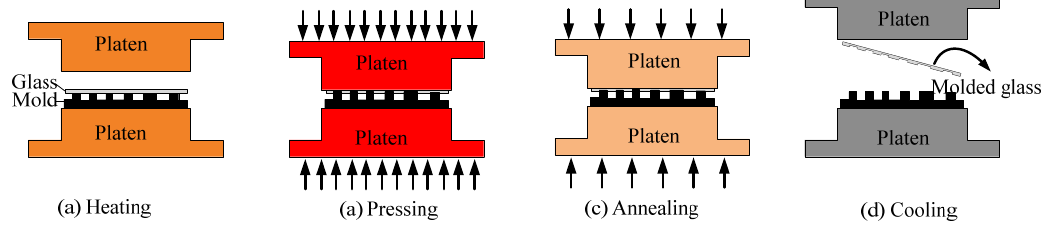
Figure 2. The schematic photo of the GMP. ( a ) Heating; ( b ) Pressing; ( c ) Annealing; ( d ) Cooling.